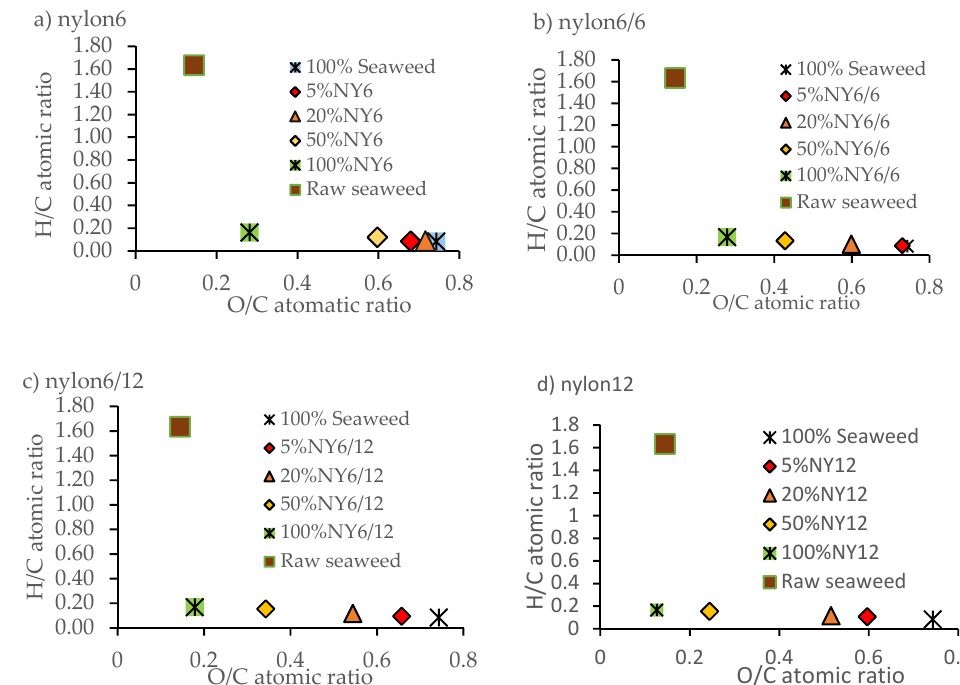
Figure 7. Van Krevelen diagram with H: C and O: C molar ratio of biochar samples created from coliquefaction of macroalga with ( a ) nylon 6, ( b ) nylon 6/6, ( c ) nylon 6/12, ( d ) nylon 12 .